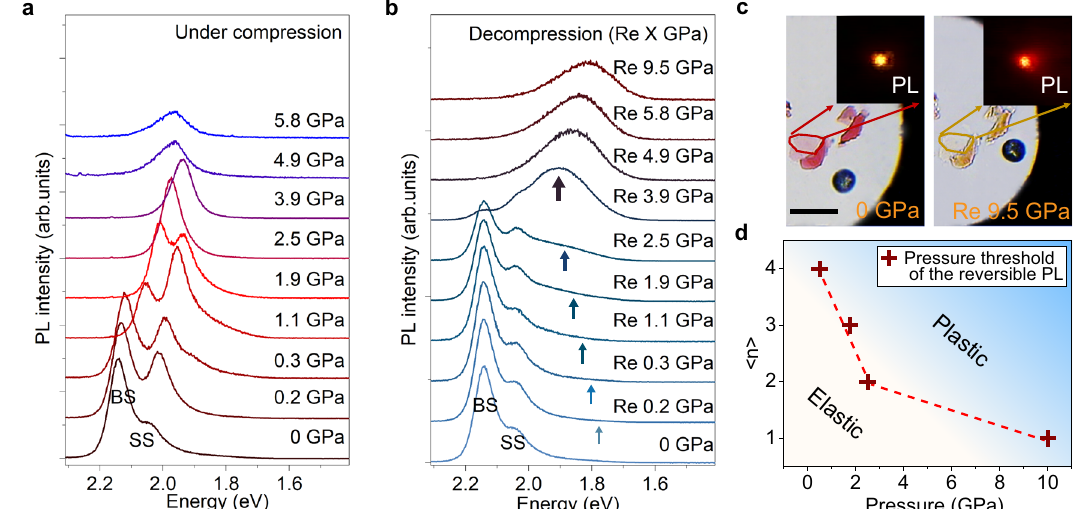
Fig. 5 | PL characterization of the reversible and irreversible deformation in RPP. In - situ PL spectra of n =2 RPP; individual spectrum in ( a ) shows compression atspeci fi c “ X ” GPa, and the corresponding spectrum in ( b ) after decompression of “ X ” GPa indicated as Re “ X ” GPa. The blue arrows in gradient color represent the proportion of the broadband emission. c Optical photographs and fl uorescence imagesof n =2RPPexfoliated fl akesbeforeandafterpressuretreatments.Scalebar